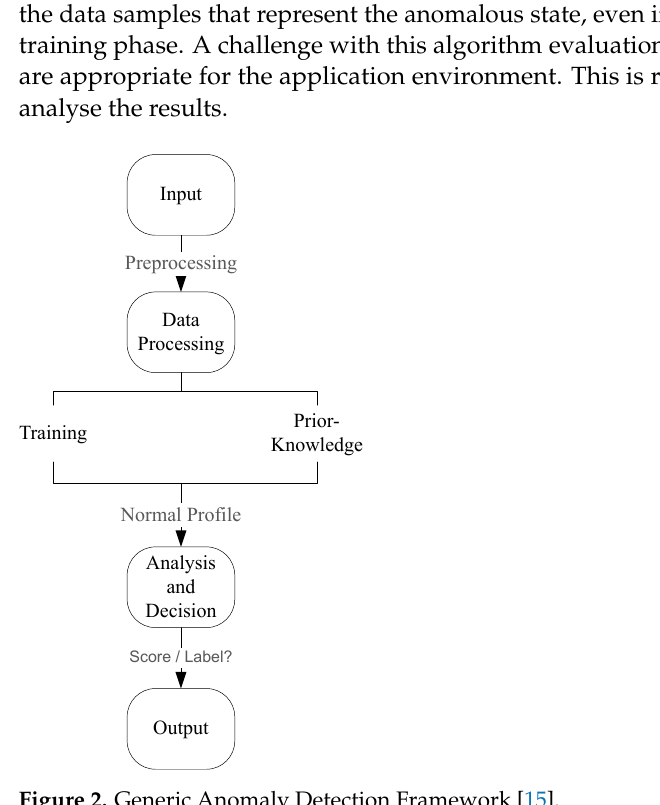
Figure 2. Generic Anomaly Detection Framework